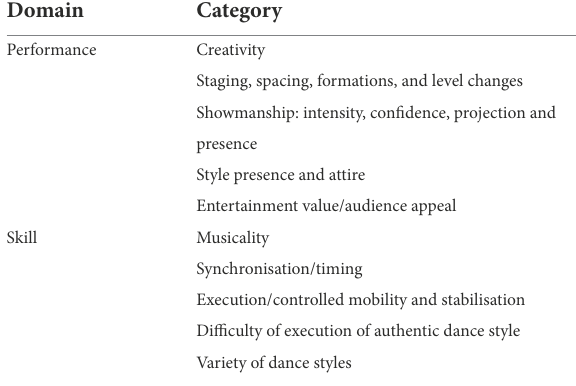
TABLE 1 Ten categories used in the most well-known hip-hop dance competitions. Domain